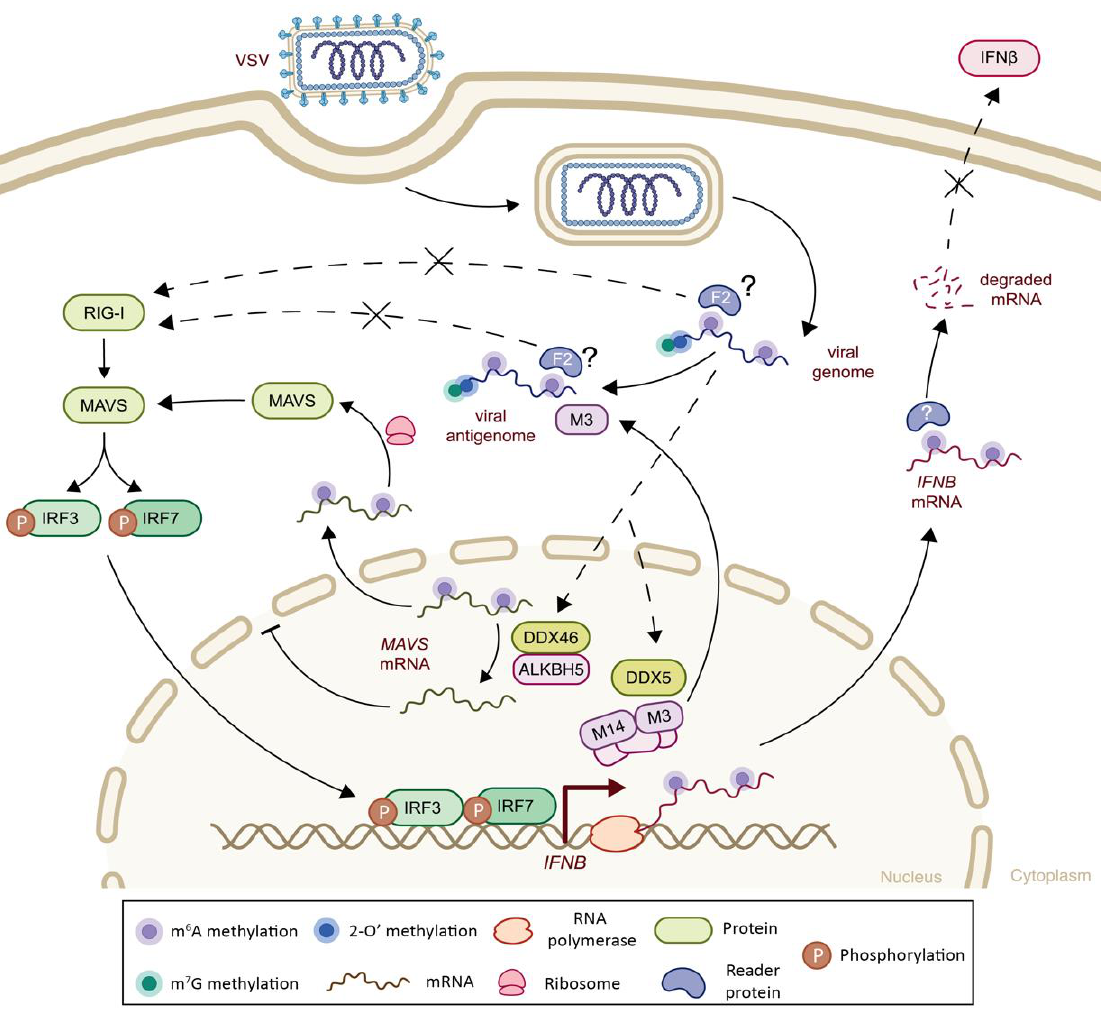
Figure 5. The impact of epitranscriptomic methylations on IFN-I response during VSV infection. Vesicular stomatitis virus (VSV) genome and antigenome carry a cap structure (m 7 G and 2 ′ -O methylations at its 5′ end, filled blue and green circles, respectively), added by its own methyltransferase, L protein (not shown). M 6 A methylations (filled purple circles) of both the VSV genome and the antigenome inhibit RIG-I sensing and downstream IFN-I response, potentially through an interaction with YTHDF2 protein (F2, light blue). During VSV infection, METTL3 (and possibly other components of the m 6 A writer complex) translocates to the cytoplasm to methylate newly transcribed viral mRNAs. Moreover, upon VSV infection, DDX46 recruits the ALKDH5 m 6 A eraser protein and demethylates MAVS , TRAF3 (not shown) and TRAF6 (not shown) mRNAs, thereby inhibiting their cytoplasmic translocation. Additionally, DDX5 interacts with METTL3 and enhances the METTL3 – METTL14 complex formation. Virally induced enhancement of the m 6 A machinery increases the m 6 A methylations of host transcripts including IFNB, p65 (not shown), IKK γ (not shown), and DHX58 (not shown). The increased m 6 A methylation of IFNB increases its mRNA degradation and hence IFNβ protein levels. F2: YTHDF2; M3: METTL3 ; M14: METTL14.